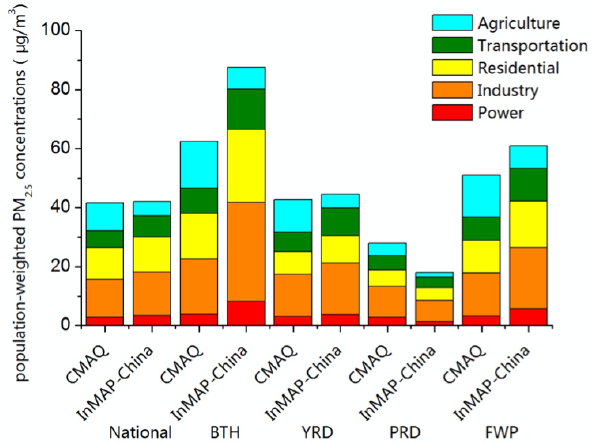
Figure 9. Comparison of source contributions to population- weighted PM 2 . 5 concentrations estimated by the two models.